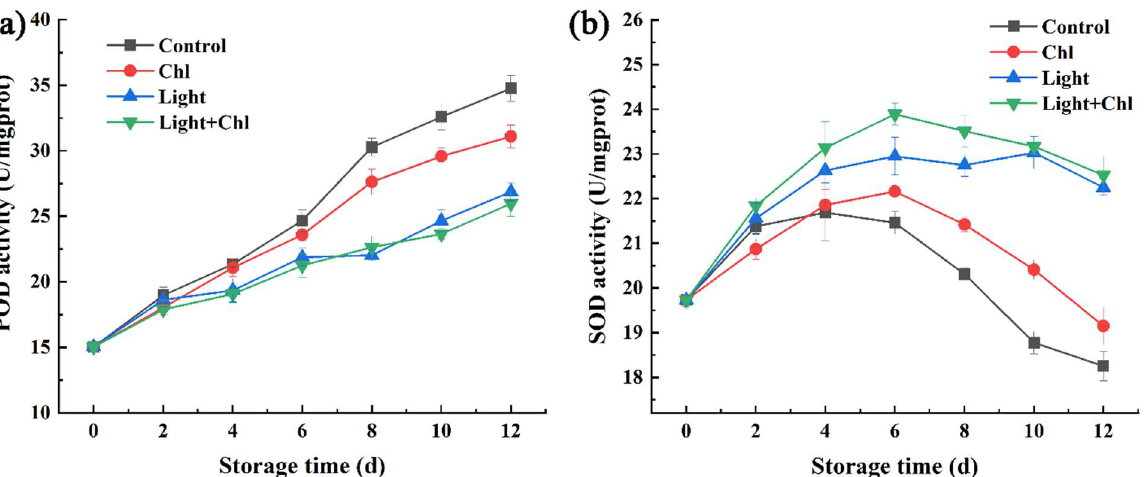
Figure 9. Changes in POD ( a ) and SOD ( b ) activity of samples. Error bars represent the mean ± SE ( n = 3).